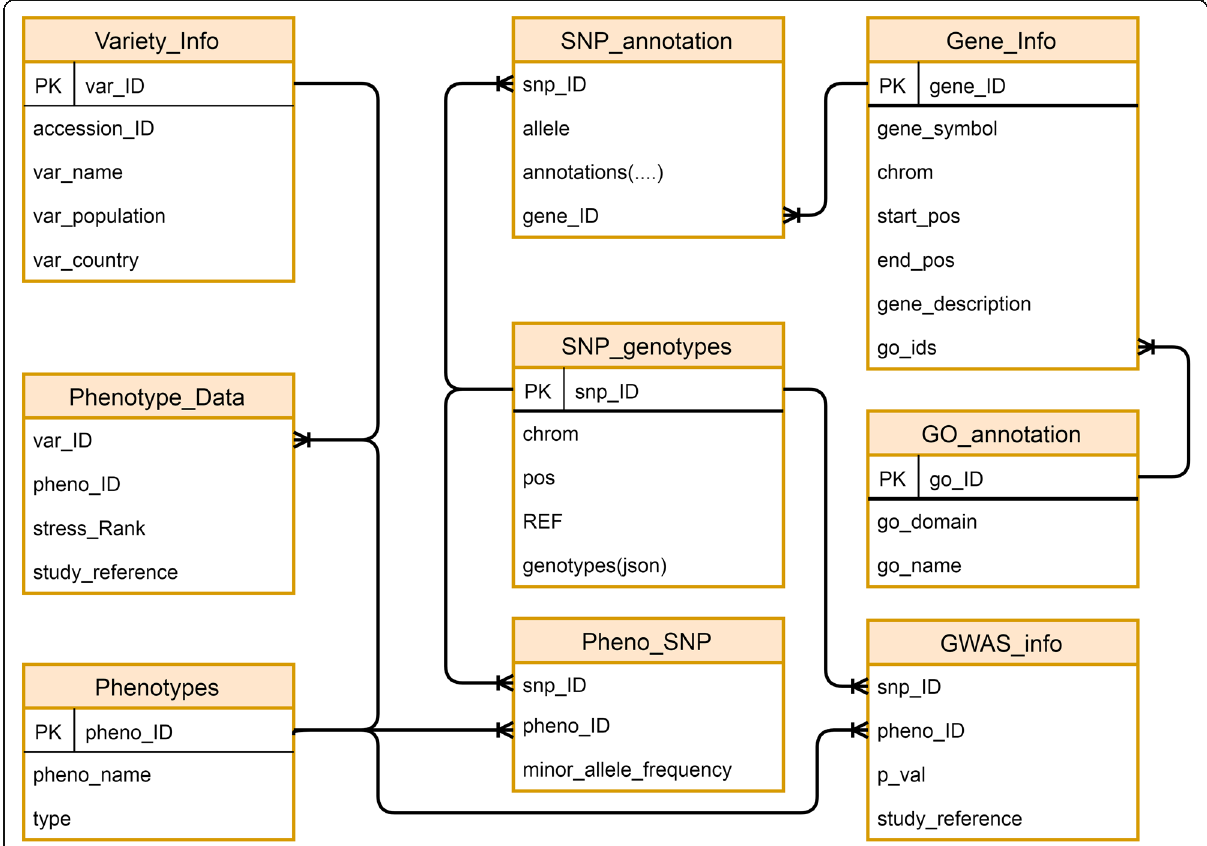
Fig. 2 Entity-Relationship Diagram for the RSRS database. The Pheno_SNP table is the table, which connects the phenotype details with the genotype details. In this table the pheno_ID field is used to identify the associated stress with the varieties and the snp_ID is used to identify the associated SNPs with the varieties. The Pheno_SNP table have a 1:N relationship with the Phenotypes and SNP_genotypes tables using pheno_ID and snp_ID keys. The SNP_genotypes table describes the detail of each SNP, which is characterized by its own unique ID, snp_ID, chrom, position, reference allele and genotypes of each accession. A SNP may consist of multiple alleles in which the annotation of each allele is stored in the SNP annotation table. The SNP_annotation table is connected in a 1:N relationship with the Gene_info table, which stores the detail of each gene. The Gene_Info table is connected to the GO_annotation table to characterize the associated genes with each SNP. The variety and phenotype details are stored in Variety_Info, Phenotype_data and Phenotypes table, var_ID and pheno_ID are used to connect these tables. The GWAS_info table stores the associated GWAS record of each SNP with its associated stress. The ER diagram was created by using draw.io at